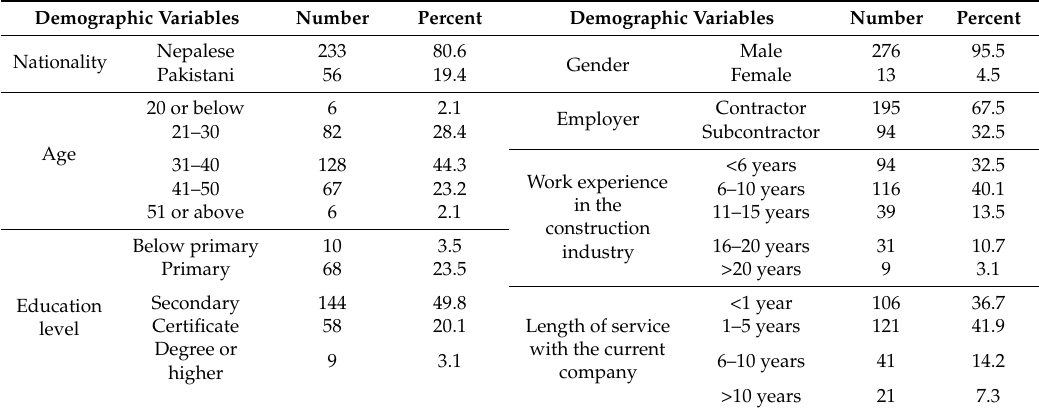
Table 2. Demographic information of the questionnaire survey respondents.